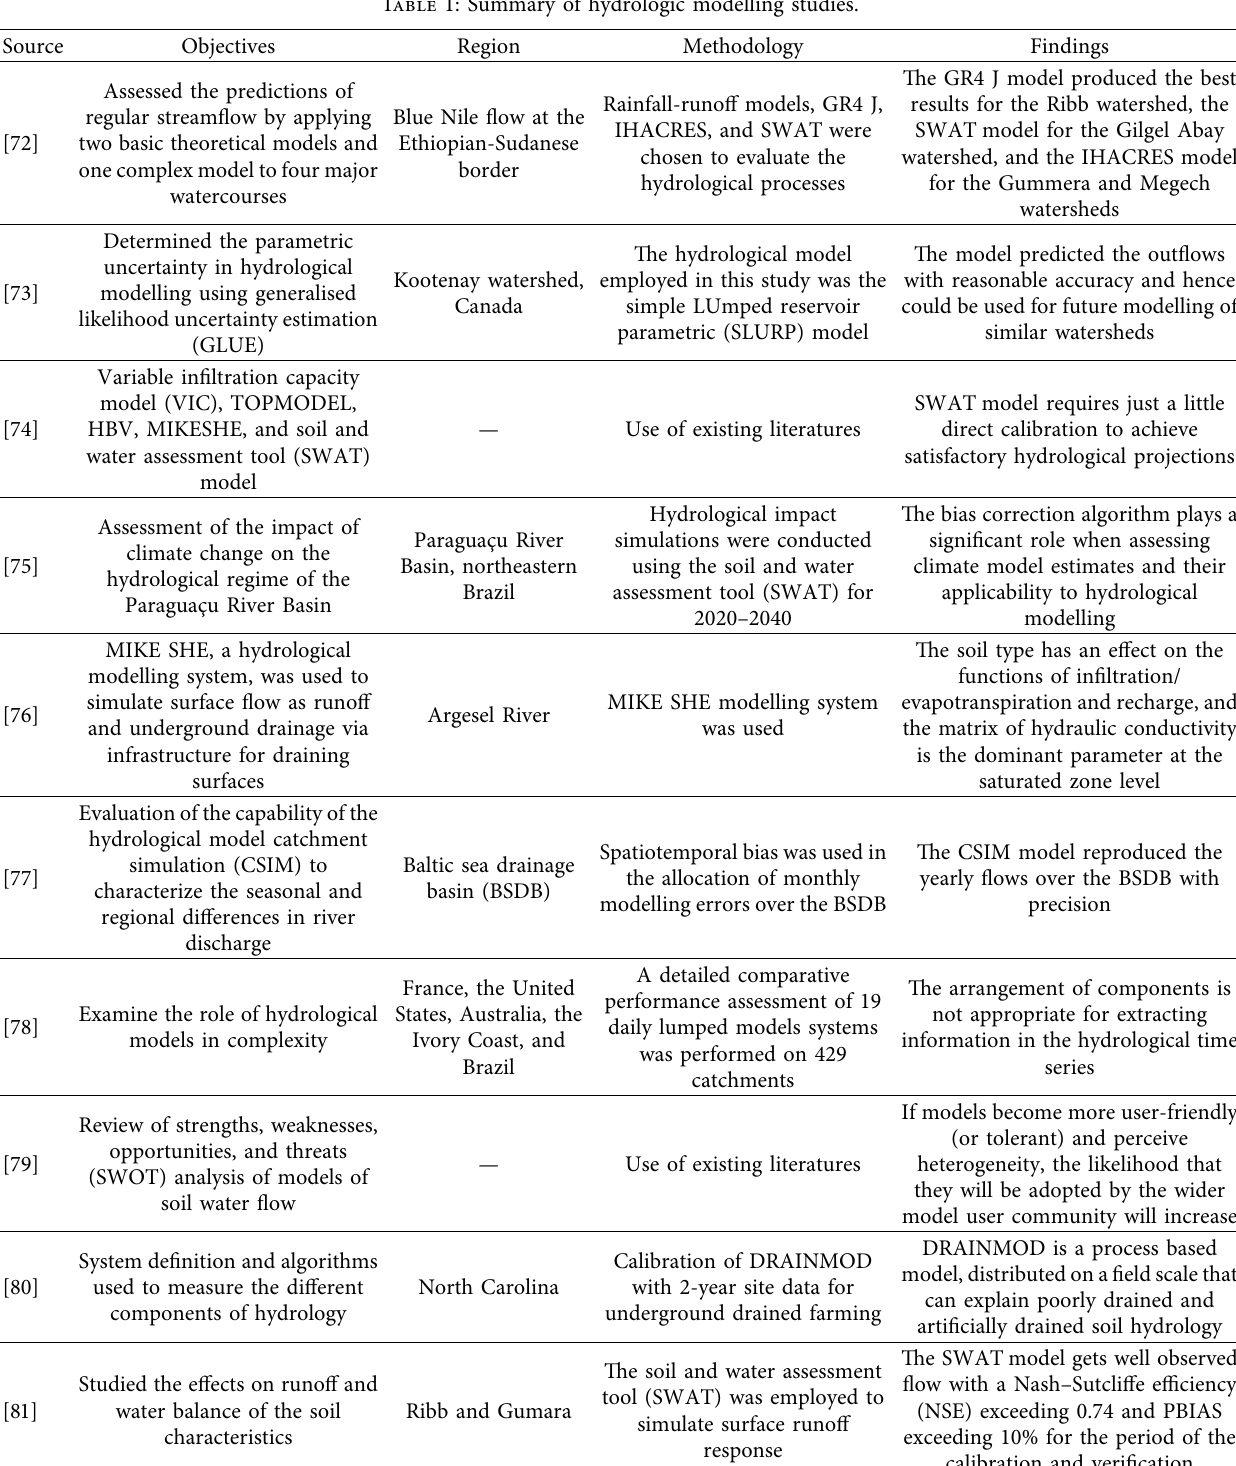
Table 1: Summary of hydrologic modelling